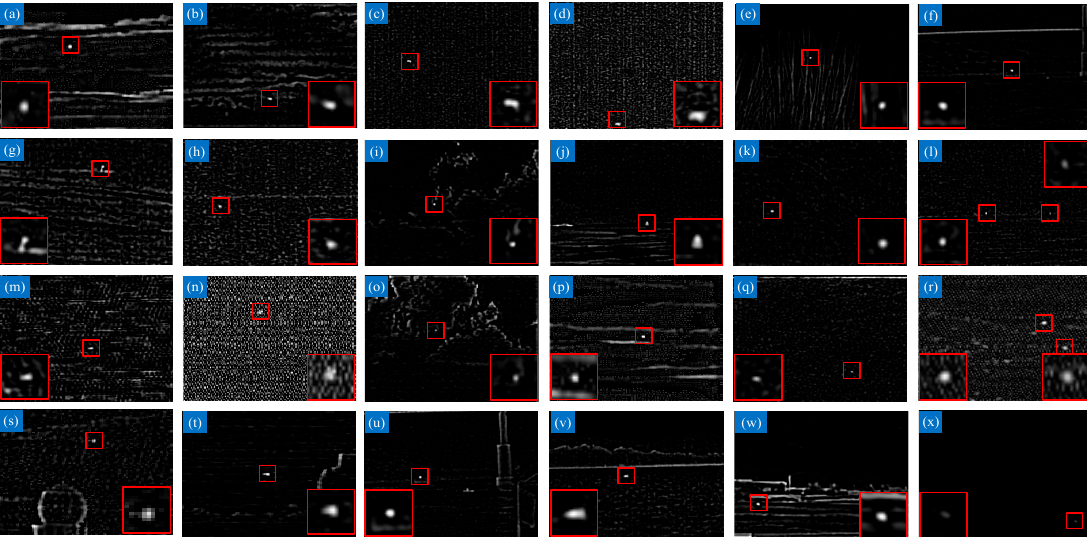
Figure A2. The separated target images of LoG under 24 scenes.